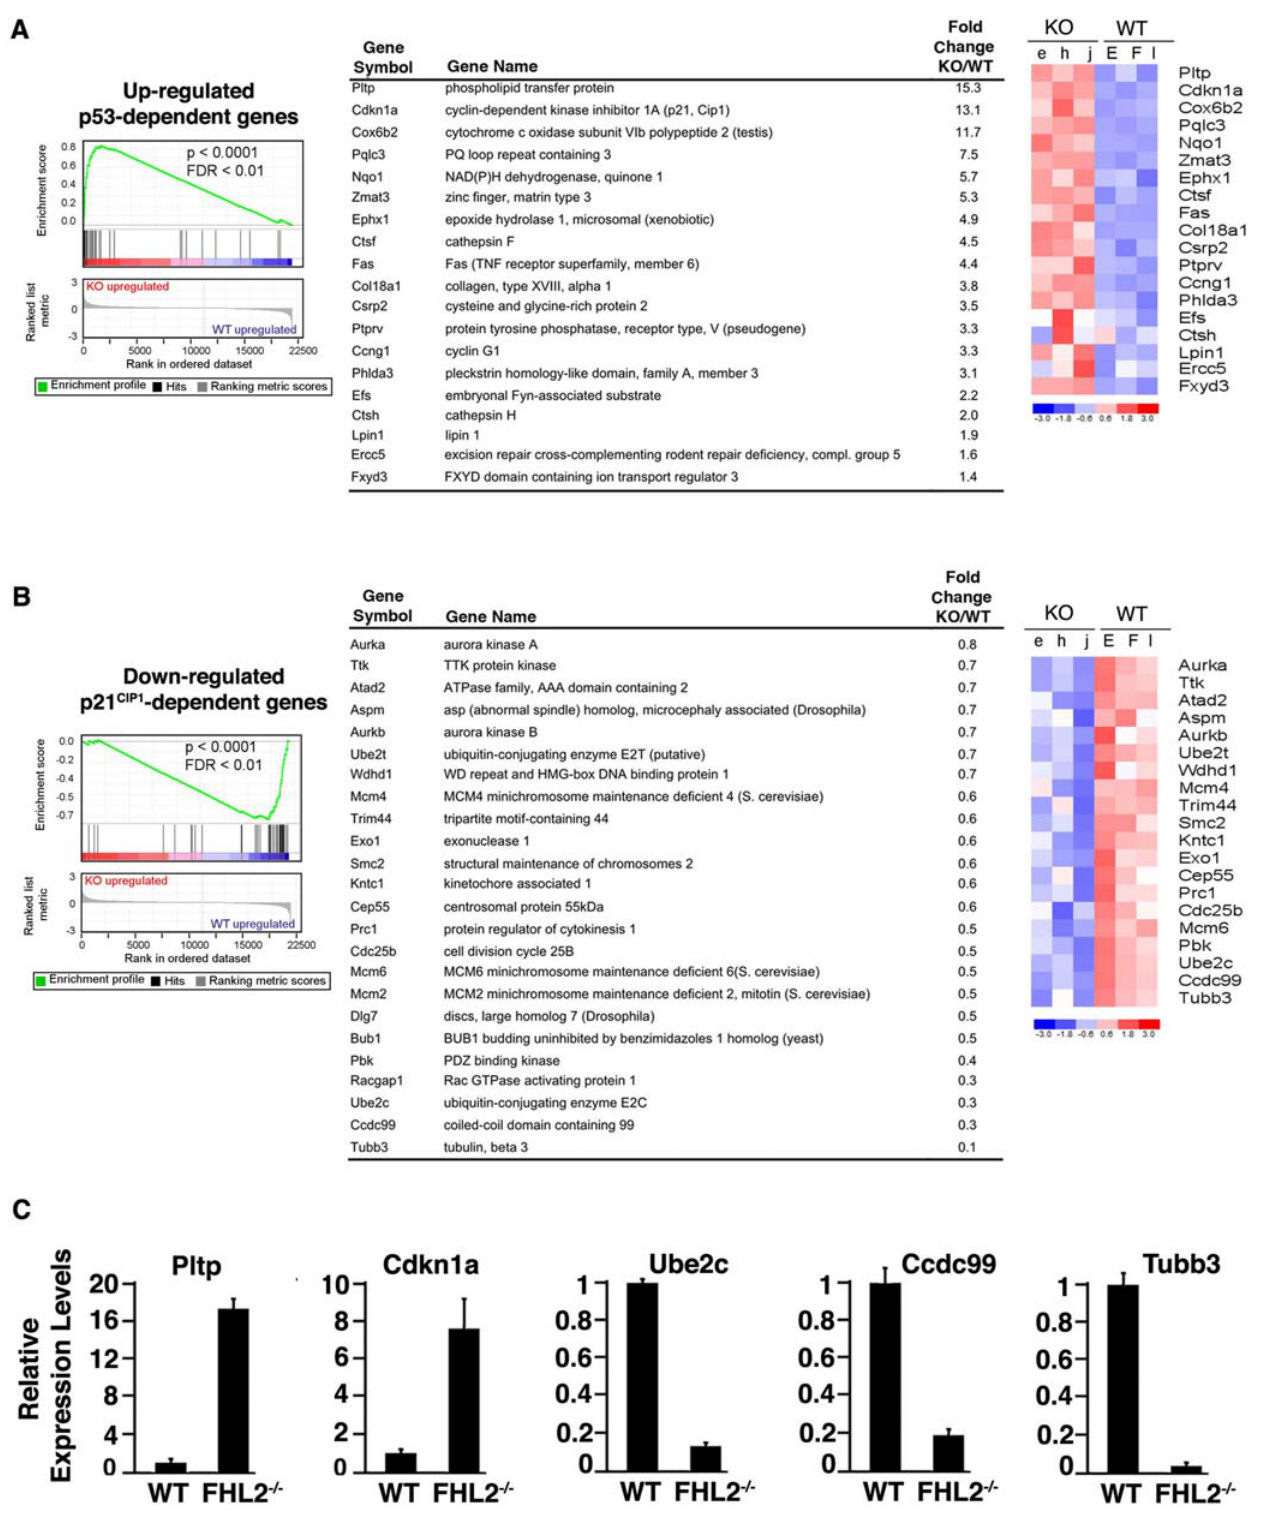
Figure 4 . Expression of p53 and p21 CIP1 target genes in FHL2 -null cells (A) Left: GSEA plot using a gene set of up-regulated p53-dependent genes from the Molecular Signatures Database (MSigDB) (NES=2.35, FDR , 0.01, p , 0.0001). Enrichment score (ES) reflects the correlation of the gene set with FHL2 2 / 2 (KO) and WT genotypes. Middle: Core group of genes of the up-regulated p53-dependent gene set that contributed to the ES. The fold change (KO/WT) value for genes that have more than one probe set corresponds to the mean value. Right: Expression profile of the deregulated genes at fold change $ 1.4 in 3 different clones for each genotype. Data are plotted as a heatmap where red and blue correspond to high and low expression in log 2 -transformed scale. (B) GSEA Analysis using down-regulated p21 CIP1 -dependent gene set of MSigDB (NES= 2 2.25, FDR , 0.01, p , 0.0001). Expression profile of the top down-regulated genes at fold change # 0.8 that are differently expressed in the FHL2 2 / 2 compared to wt